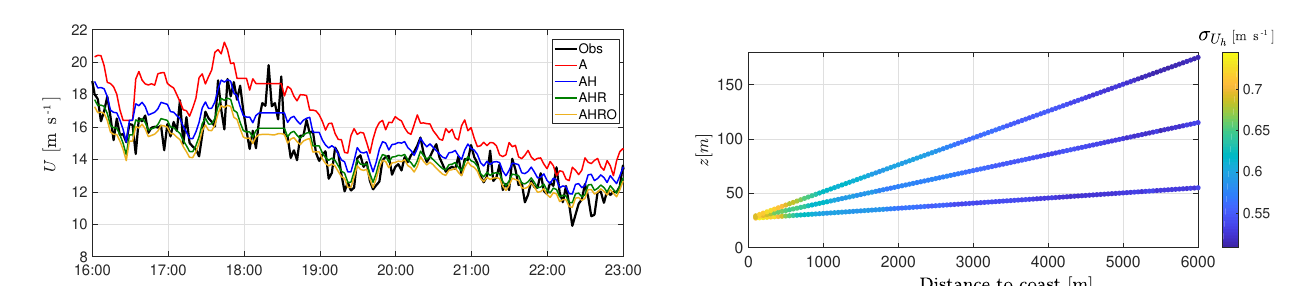
Ensemble average standard deviation of the horizontal wind speed with distance to shore for the three elevations’ angles during all periods